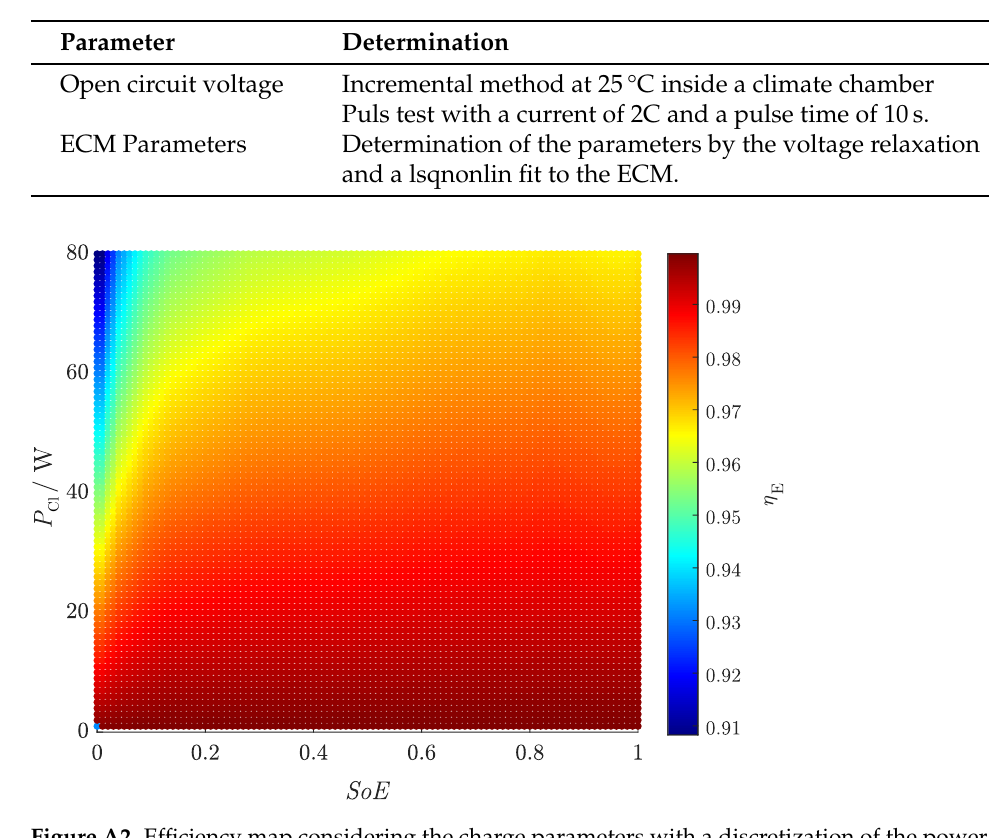
Figure A2. Efficiency map considering the charge parameters with a discretization of the power of 1 W and a discretization of the SoE of 1%.